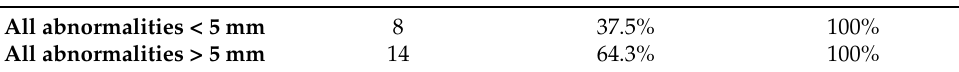
Table 6. Comparison between Chest CT scan vs. gold standard MT according to subgroup analysis of Ultrasonographic findings.